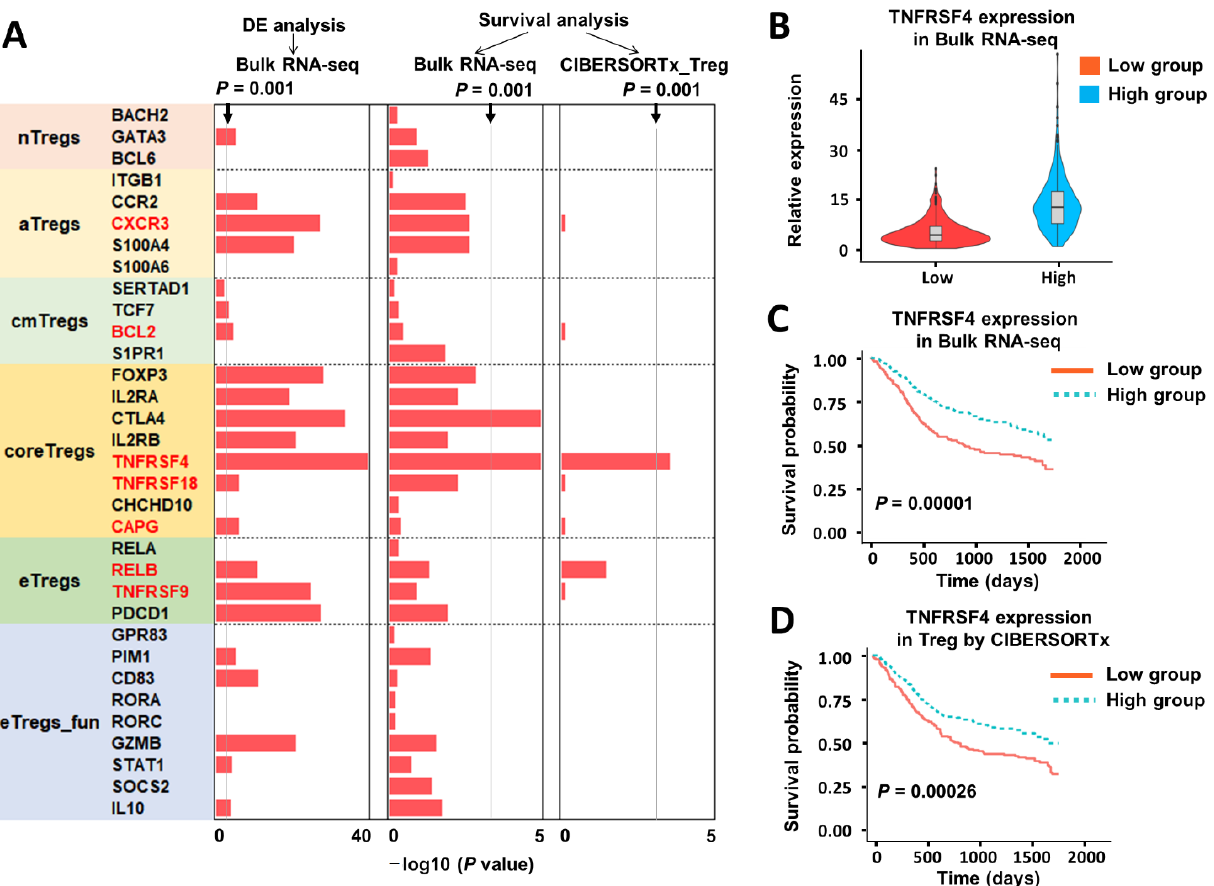
Figure 5. CIBERSORTx analysis of gene expression of regulatory T-cells (T reg ). ( A ) Bar plot of the p -values calculated from differential gene analysis of low and high group defined by T reg proportions, log-rank tests for survival outcomes of the low and high fraction groups of T reg marker genes. In the first column, gene expression is obtained from bulk RNA-seq in TCGA. In the second column, gene expression is from the T reg subpopulation estimated by CIBERSORTx. Genes marked in red have imputed values noted. Gray lines represent the p -value threshold ( p = 0.001). ( B ) Violin plot of TNFRSF4 expression in low and high group defined by T reg proportions. ( C ) Association between TNFRSF4 expression and overall survival in patients with HNSCC profiled by TCGA. Estimated cell proportions were stratified by a half–half split, and the separation between survival curves was evaluated using a log-rank test. ( D ) Association between T reg -specific TNFRSF4 expression estimated by CIBERSORTx and overall survival in patients with HNSCC profiled by TCGA. The same calculation method is performed as in ( C ). Table 4. Cox proportional-hazard regression analysis for survival and TNFRSF4 expression estimated by bulk RNA-seq and CIBERSORTx (prop., proportion; HR, hazard ratio; CI, confidence interval; ref, reference).